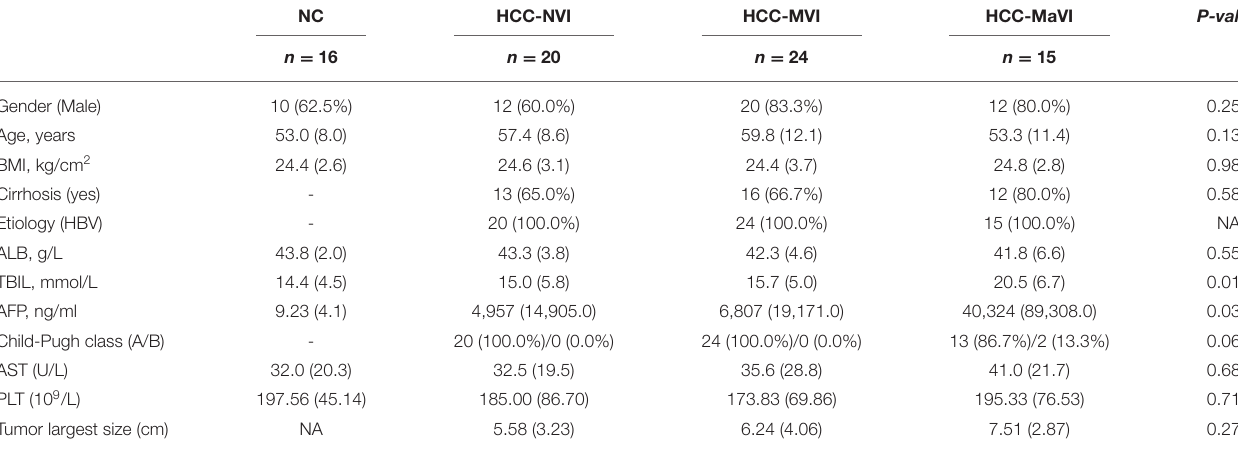
TABLE 1 | Clinical characteristics of all